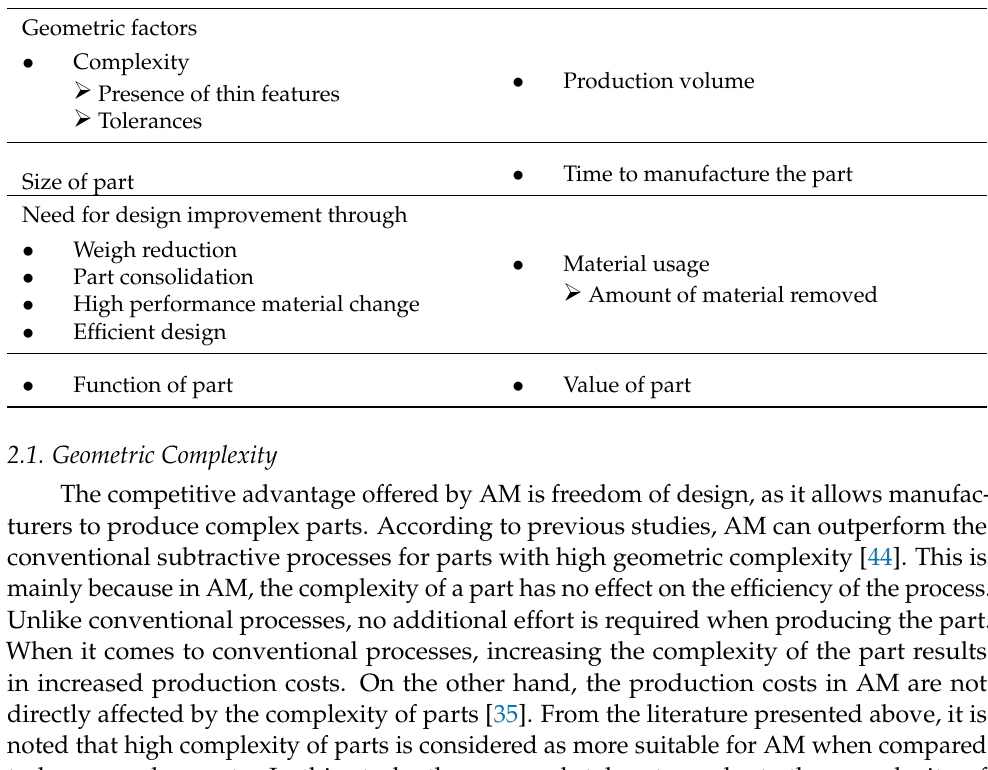
Table 2. Summary of the parameters from the